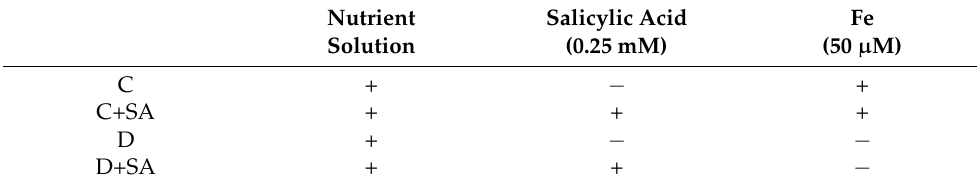
Table 1. Treatments applied to Sulla carnosa seedlings.